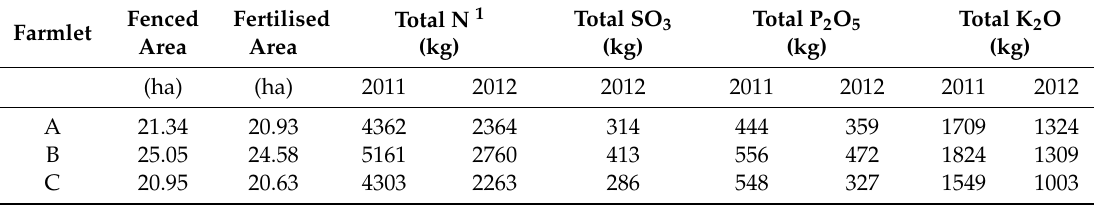
Table 1. Inorganic N, P 2 O 5 and K 2 O fertiliser applications in 2011 and 2012 and SO 3 fertiliser applications in